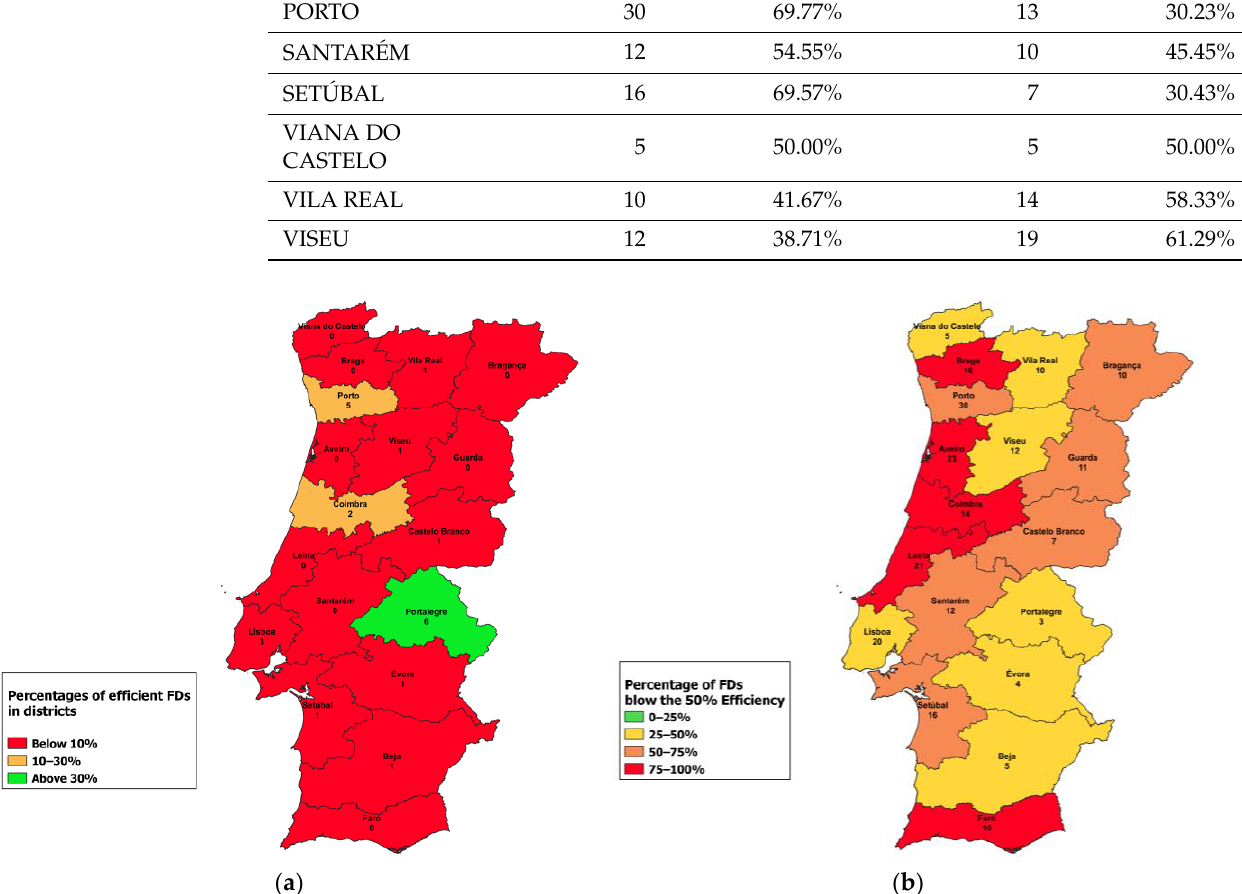
Figure 7. ( a ) Number and percentage of efficient FDs in each district. ( b ) Number and percentage of FDs with less than 50% efficiency in each district.